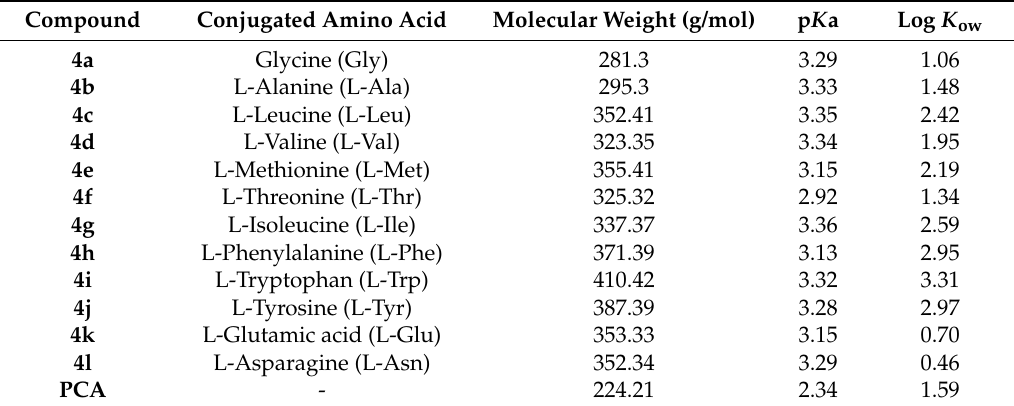
Table 4. Physicochemical properties of compounds 4a – l and